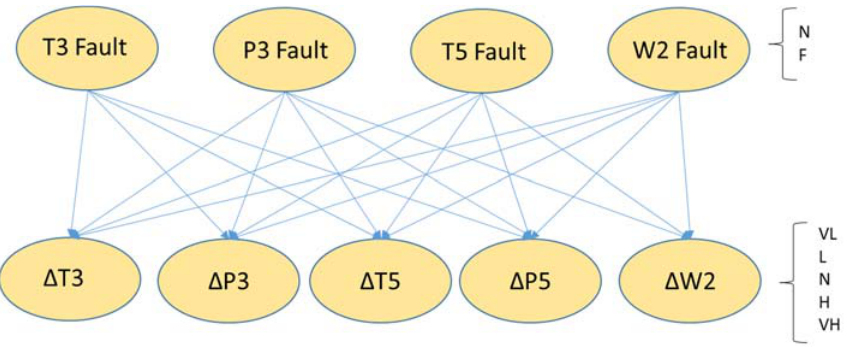
Figure 3. The static BN for sensor faults detection (sensor state is normal (N) or faulty